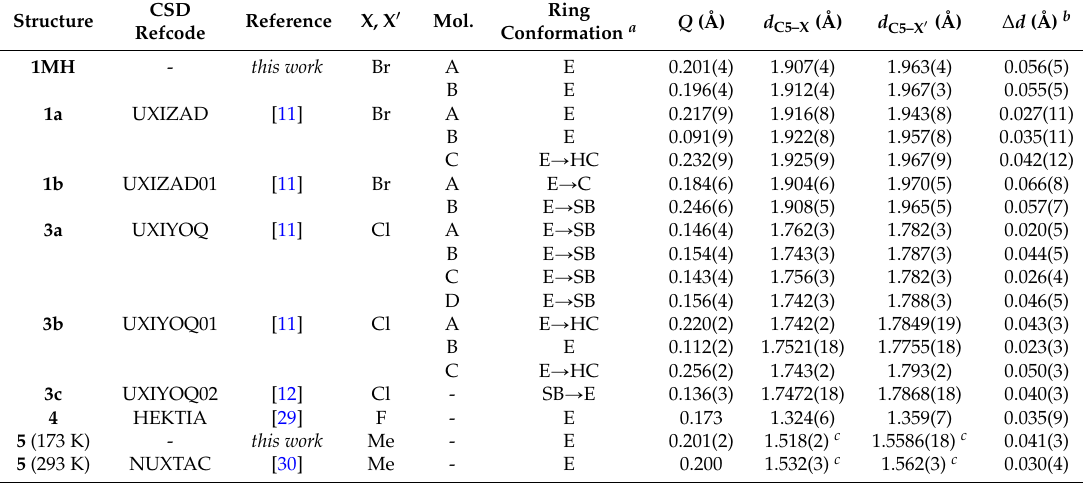
Table 4. Conformation and puckering amplitudes Q [17] of pyrimidine rings, equatorial ( d C5–X ) and axial ( d C5–X 1 ) bond distances at ring atom C5 for the independent molecules (A, B . . . ) in the crystal structures of dibromobarbituric acid ( 1 ) and several close analogues ( 3 – 5 ; see Scheme 1).